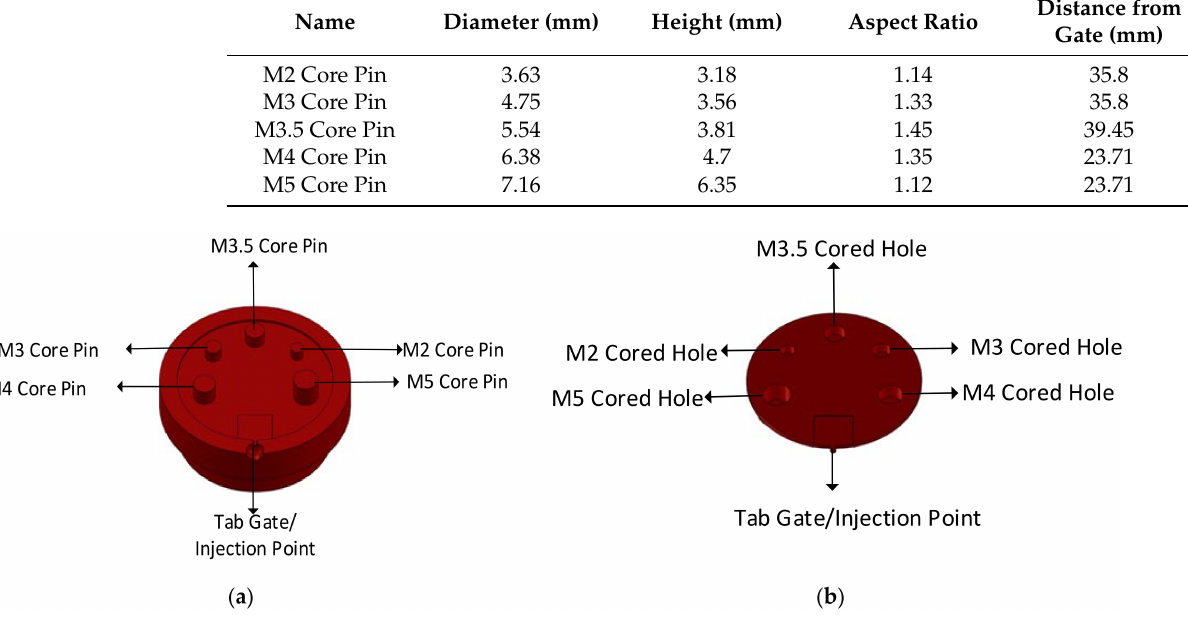
Figure 2. ( a ) Core side of 3DIM showing the raised features (core pins); ( b ) face of the part formed by the core insert.